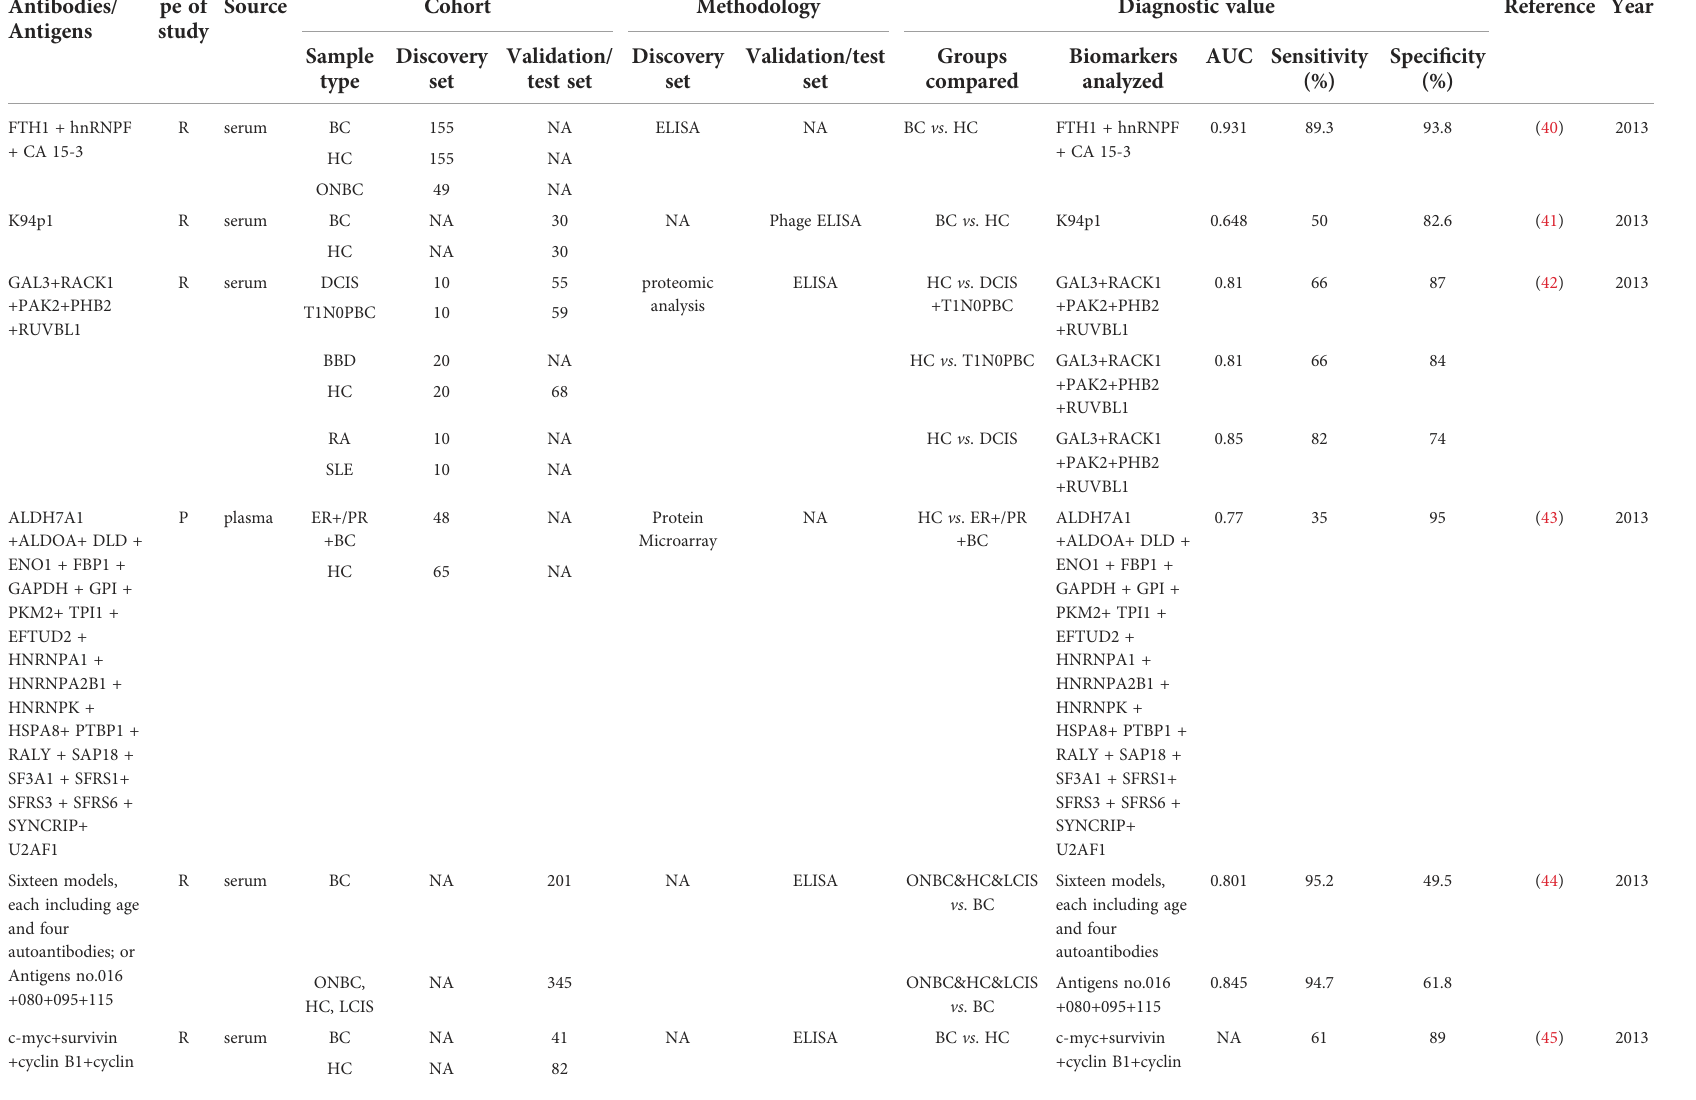
TABLE 1 Autoantibodies in the Diagnosis of Breast